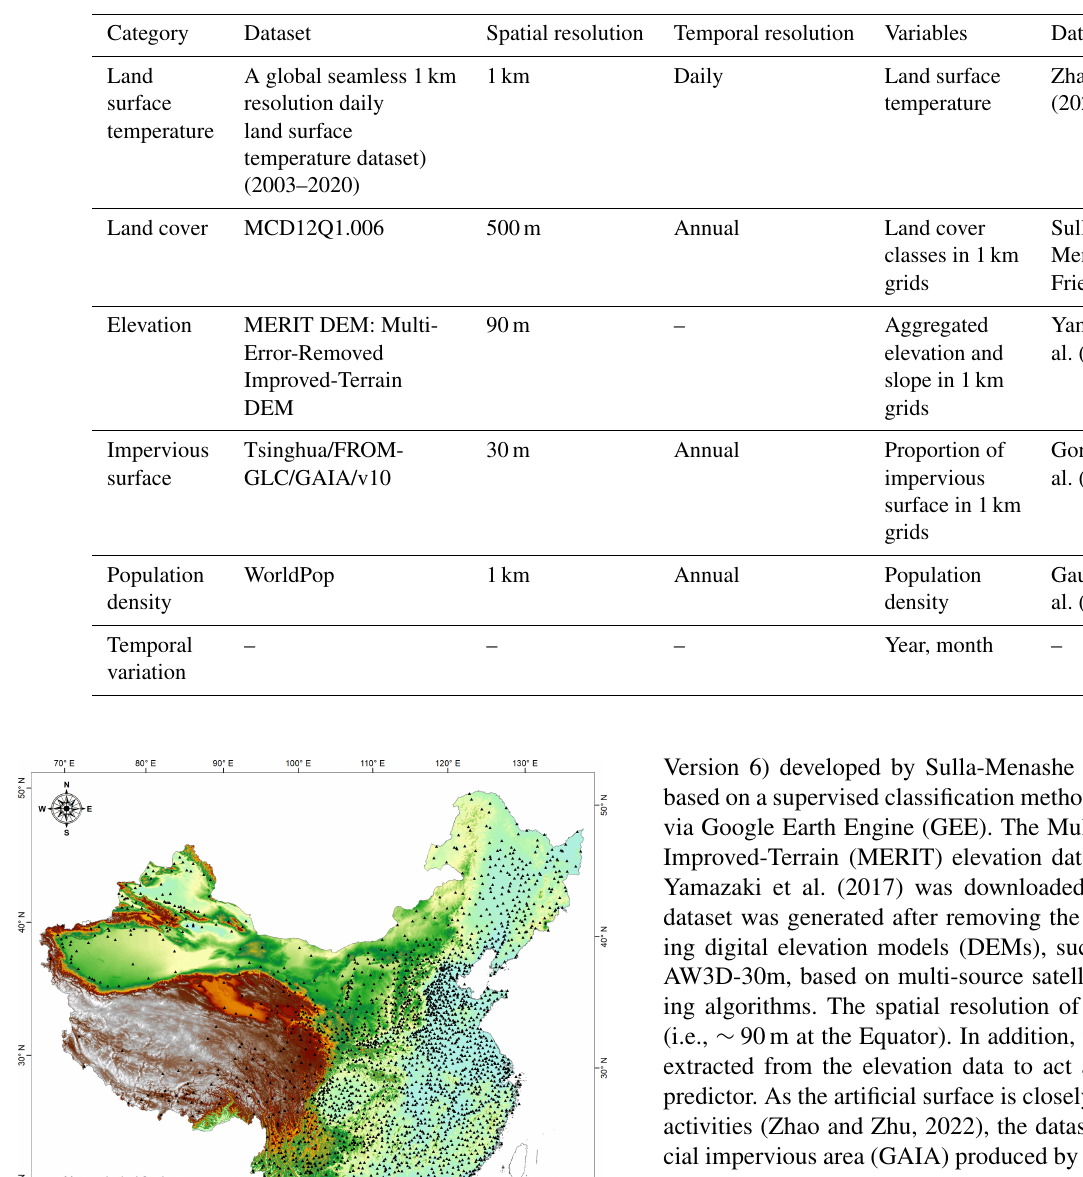
Table 1. Gridded datasets used in this study.